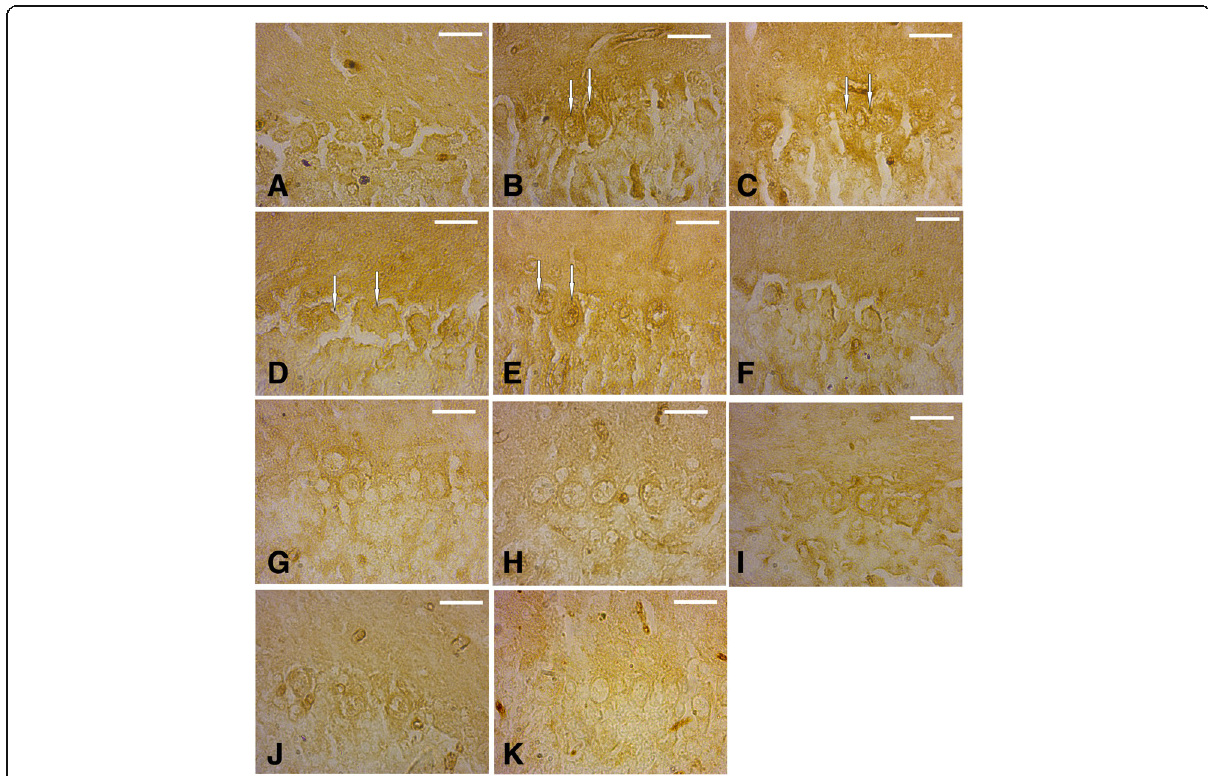
Fig. 7 Photomicrographs of immunohistochemistry of α -synuclein in the cerebellar region of the control group ( a ). The acrylamide-administrated groups showed a gradual increase in expression from 30 days (arrows, b ) and 45 days (arrows, c ) and denser in 60 days of administration (arrows, d ). The chips feeding group showed increase of intracellular expression (arrows, e ). The BV- and BPF-treated groups showed nearly the same expression of the control ( f , g ). The acrylamide-administrated groups treated with either BV ( h ) or BPF ( i ) showing downregulated expression of α -synuclein expression compared to acrylamide-induced overexpression. The chips feeding groups treated with either BV ( j ) or BPF ( k ) showed the normal expression and distribution of staining similar to the control. Immunostaining of α -synuclein; scale bar 5 μ